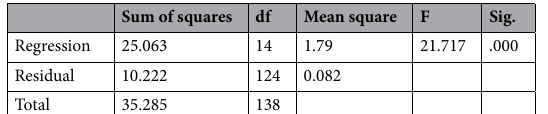
Table 2. Results of the hypothesis test of the linear regression model.